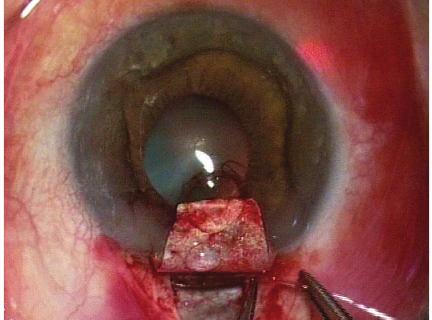
Figure 4: Cannulation of the Schlemm’s canal. The distal tip can clearly be seen through the sclera (red point at the upper right corner).